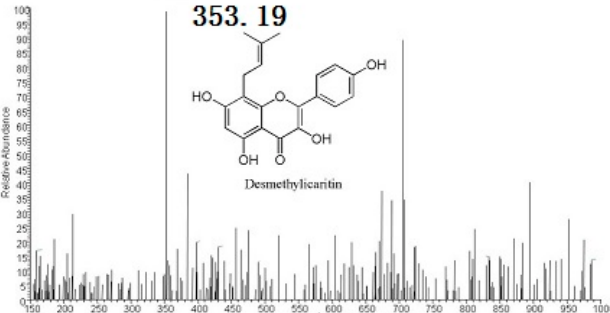
Figure 3. MS spectra of icariin and its metabolites. Thermo Fisher Scientific LCQ fleet instrument (Thermo Scientific, Waltham, MA, USA) was used for electrospray ionization mass spectrometry (ESI-MS) analysis. ESI condition: spray voltage, 5.4 kV; sheath gas, 15 arbitrary units; auxiliary gas, five arbitrary units; heated capillary temperature, 275 ° C; capillary voltage, 27 V; and tube lens, 100 V.